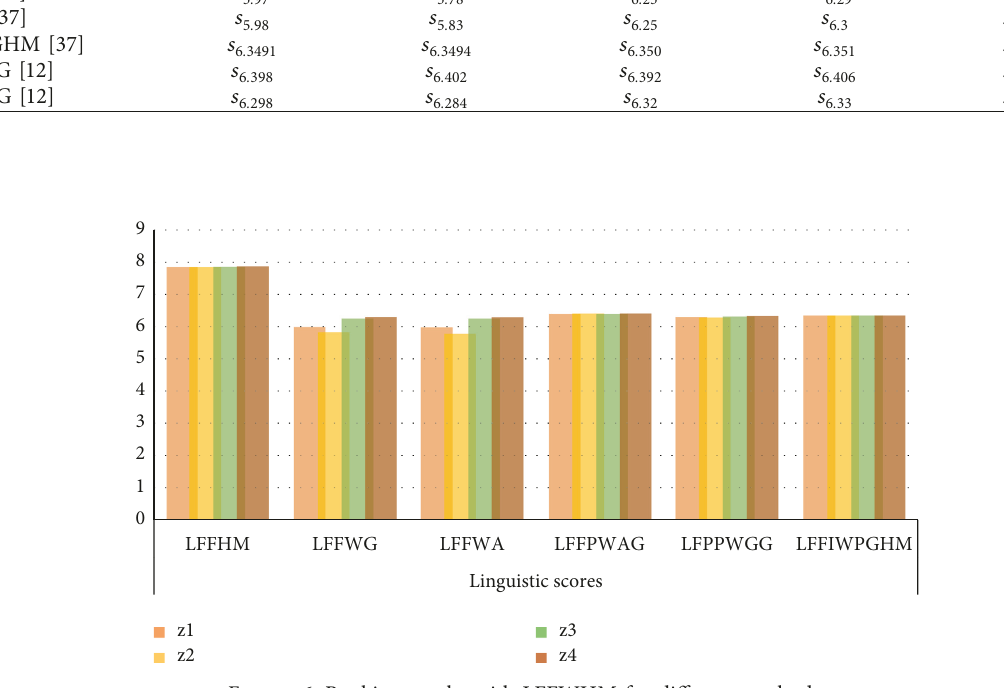
Figure 6: Ranking results with LFFWHM for different